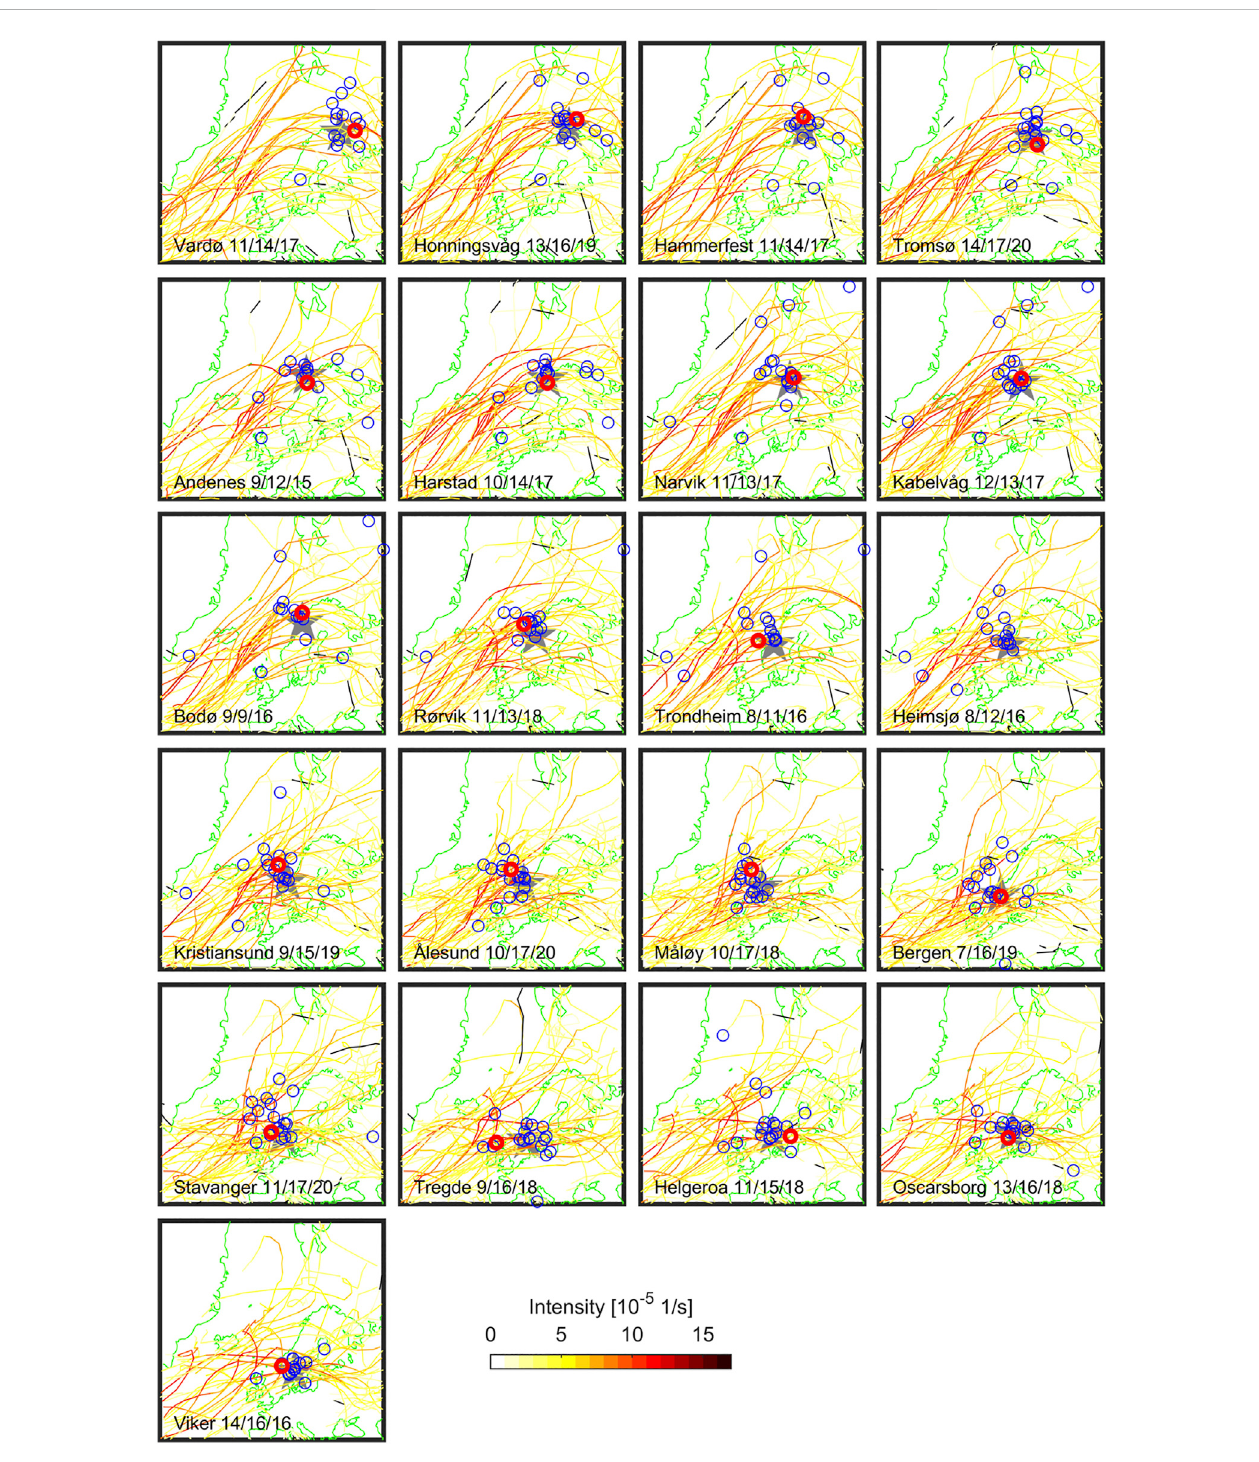
FIGURE 3 Storm tracks for the 99.9th percentile SkS for each TG. Blue rings mark the neareststorm center point atthe time of each SkS maximum (occurred ± 6 h of the maximum AT). Red rings mark the center points for the highest SkSs in the dataset. Storm track colors indicate their intensity. The location of TGs is marked with a grey star. The numbers next to the station name give the number of SkSs with storm center points closer than 500 km/1,000 km/all